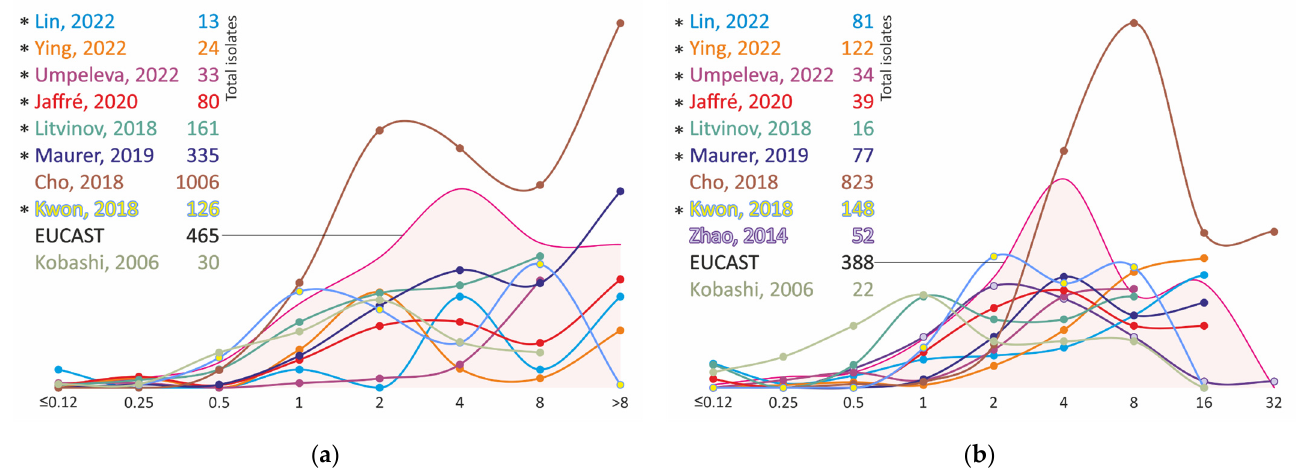
Figure 3. MIC distribution of rifampicin for clinical isolates of M. avium ( a ) and M. intracellulare ( b ). * MIC obtained using Sensititre SLOMYCO plates.